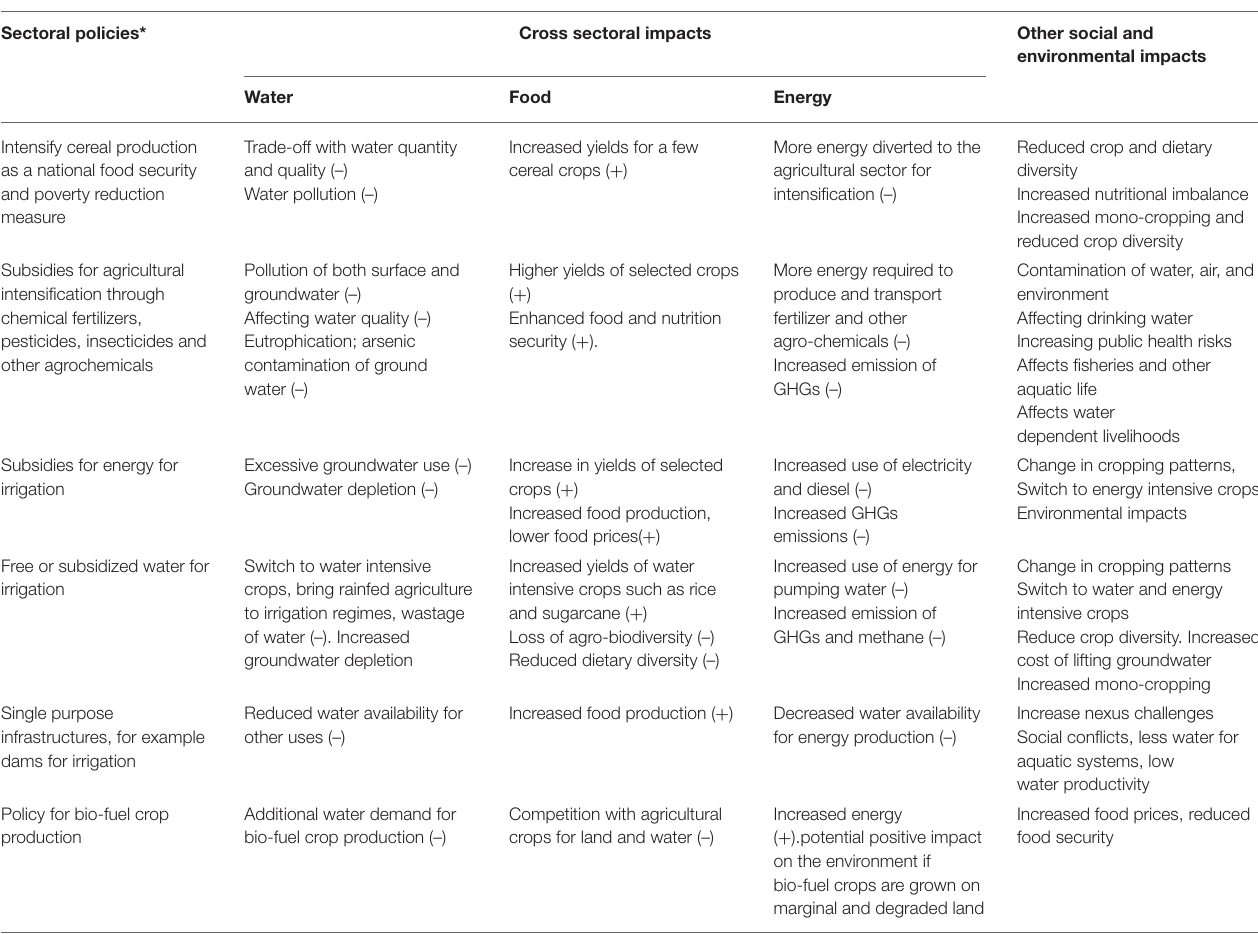
TABLE 1 | Sectoral policies and their cross-sectoral impacts. Sectoral